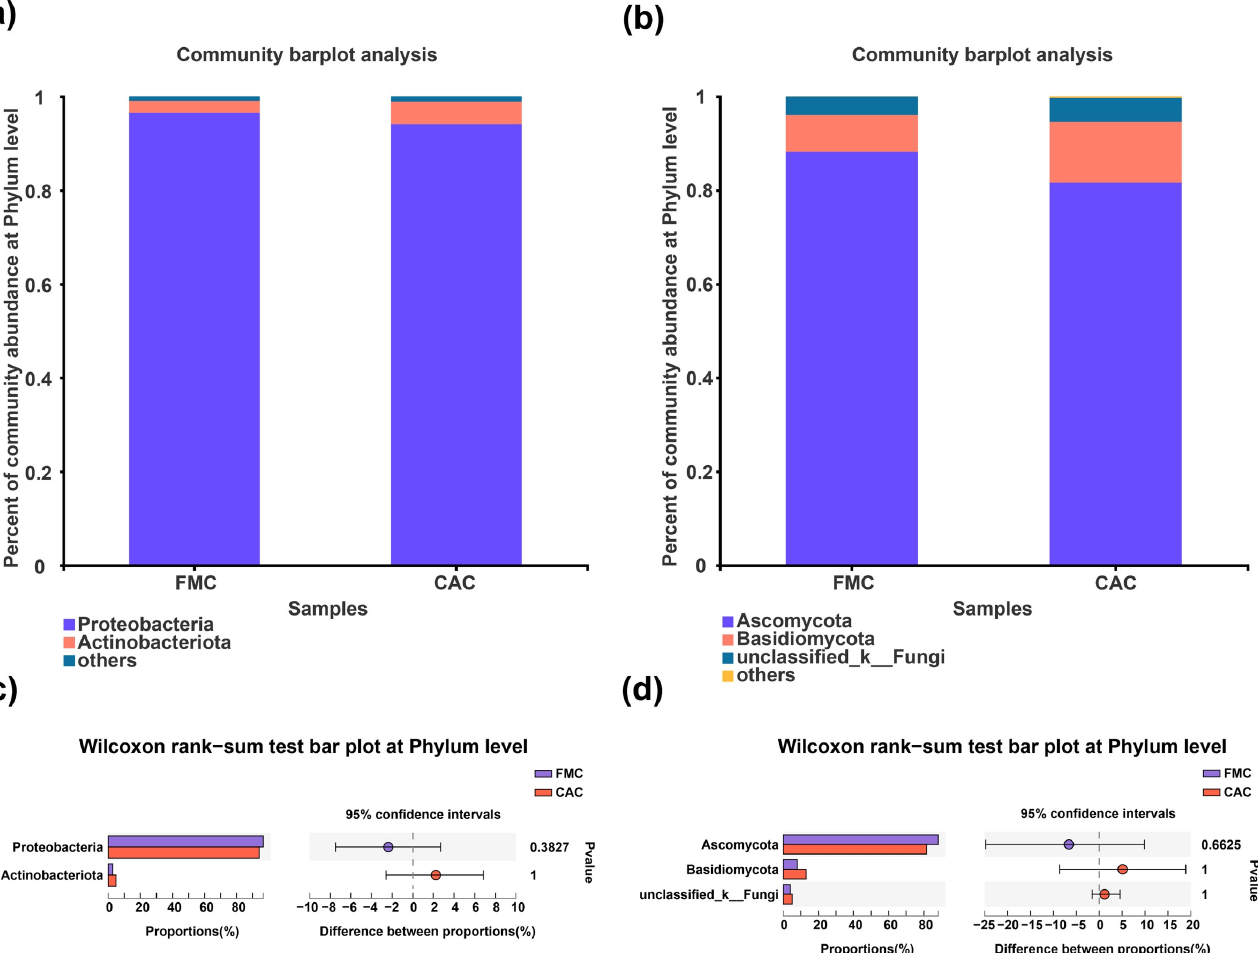
Figure 2. Compositions of endophytic microorganisms in the stems of sugarcane under FMC and CAC treatments at phylum level. ( a ) The proportions of the dominant endophytic bacteria. ( b ) The proportions of the dominant endophytic fungi. ( c ) Test for significant difference in the bacterial abundance between groups. ( d ) Test for significant difference in the fungal abundance between groups. FMC—fully mechanized cultivation; CAC—conventional artificial cultivation.